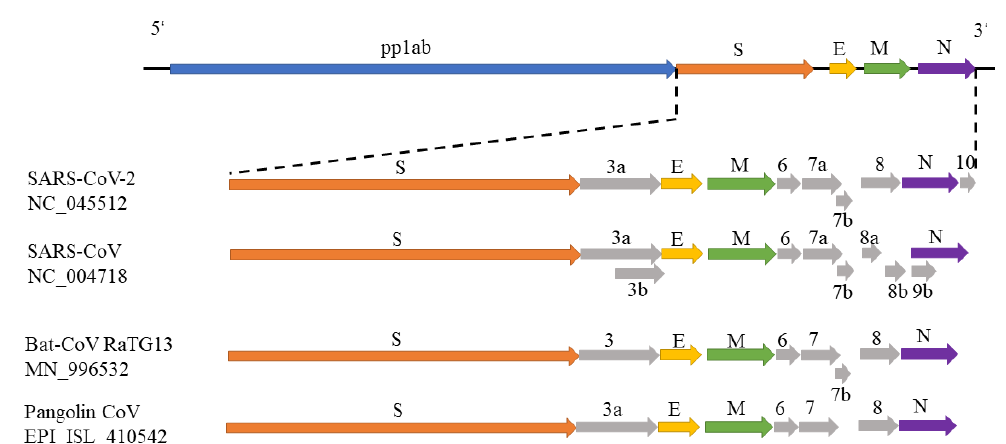
Figure 1. The genomic structures of SARS-CoV-2, SARS-CoV, bat-CoV and pangolin-CoV. The genomic structures of SARS-CoV-2 (NC_045512), SARS-CoV (NC_004718) and bat-CoV (MN_996532) were drawn according to their annotations in NCBI GenBank. The genomic structure of pangolin-CoV was drawn in